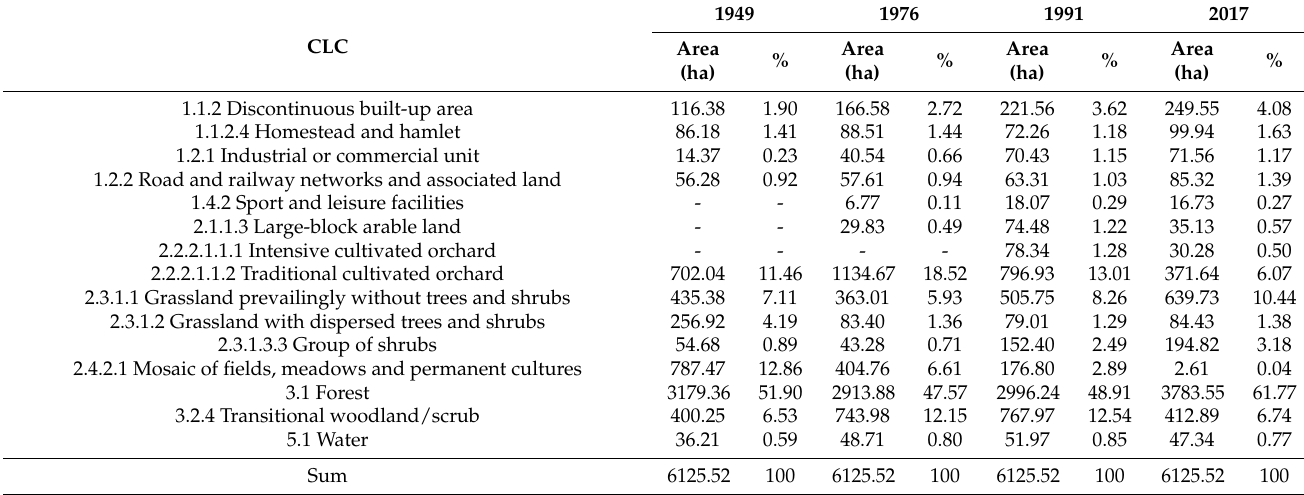
Table 3. Changes in land cover in the cadastral area of Nov á Baˇna over the period 1949–2017. CLC (CORINE Land